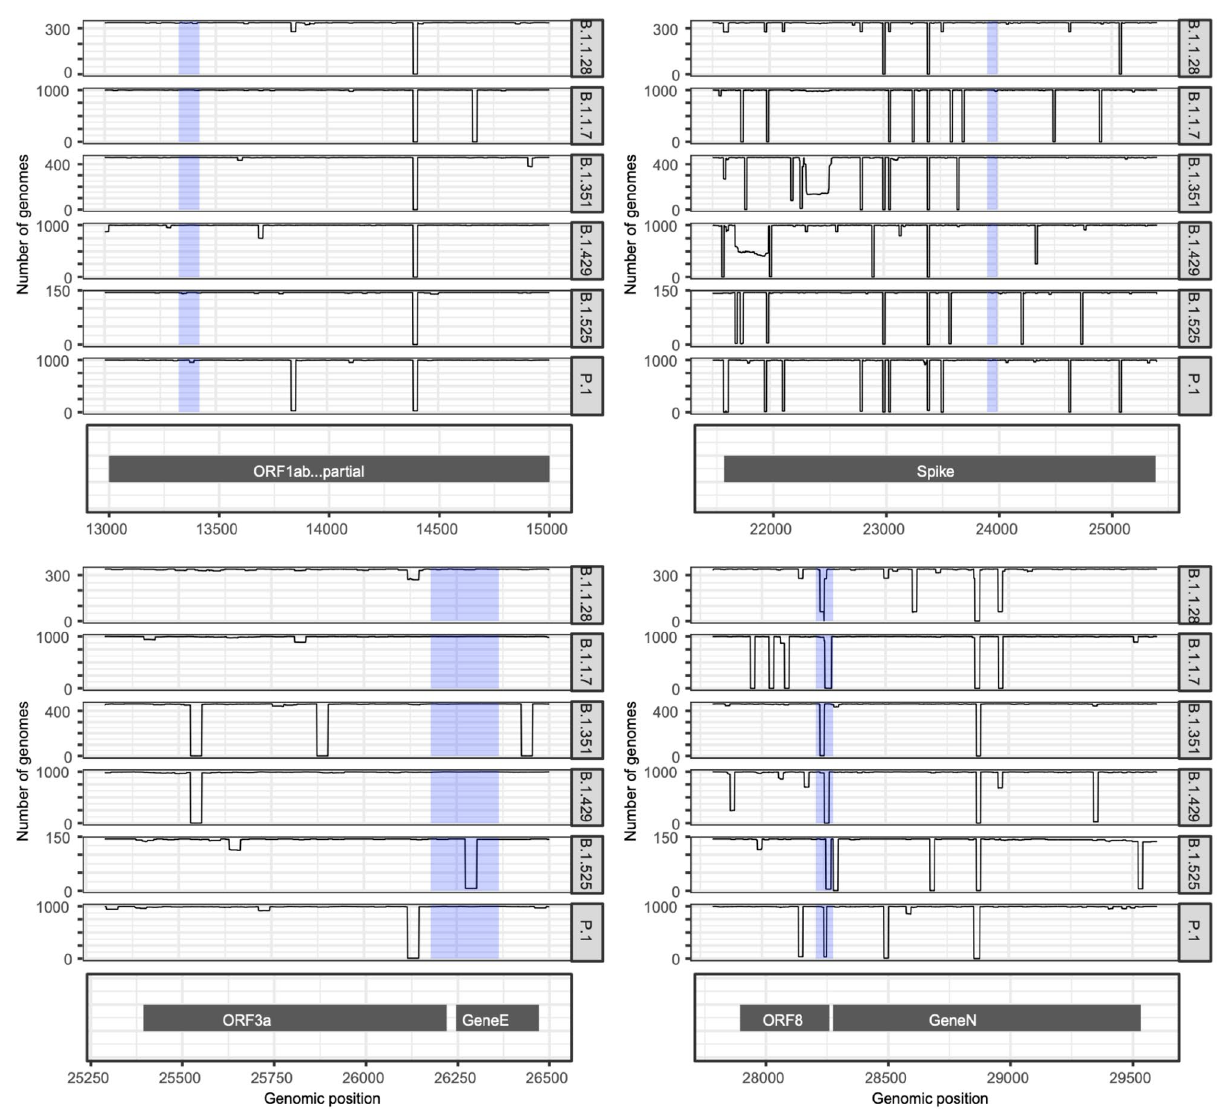
Figure 4. Number of SARS-CoV-2 population genomes that contain each reference kmer. Each plot shows each genome position at the X axis and the number of occurrences of the kmer starting at position X at the Y axis for each group of SARS-CoV-2 genomes. The shadowed blue regions represent the regions amplified by the PCR primers used in this study: upper left, primer NSP-3; upper right, primer S; lower left, primer E and lower right, primer